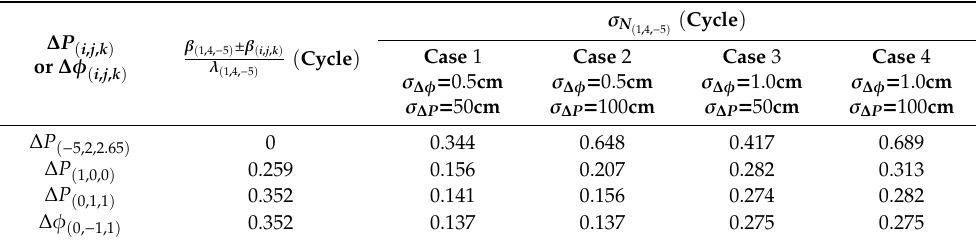
Table 1. Characteristics of the extra-wide-lane (EWL) ambiguity ∆ N ( 1,4, − 5 ) for di ff erent cases. ∆ P ( i , j , k ) or ∆ φ ( i , j , k ) ∆ P ( − 5,2,2.65